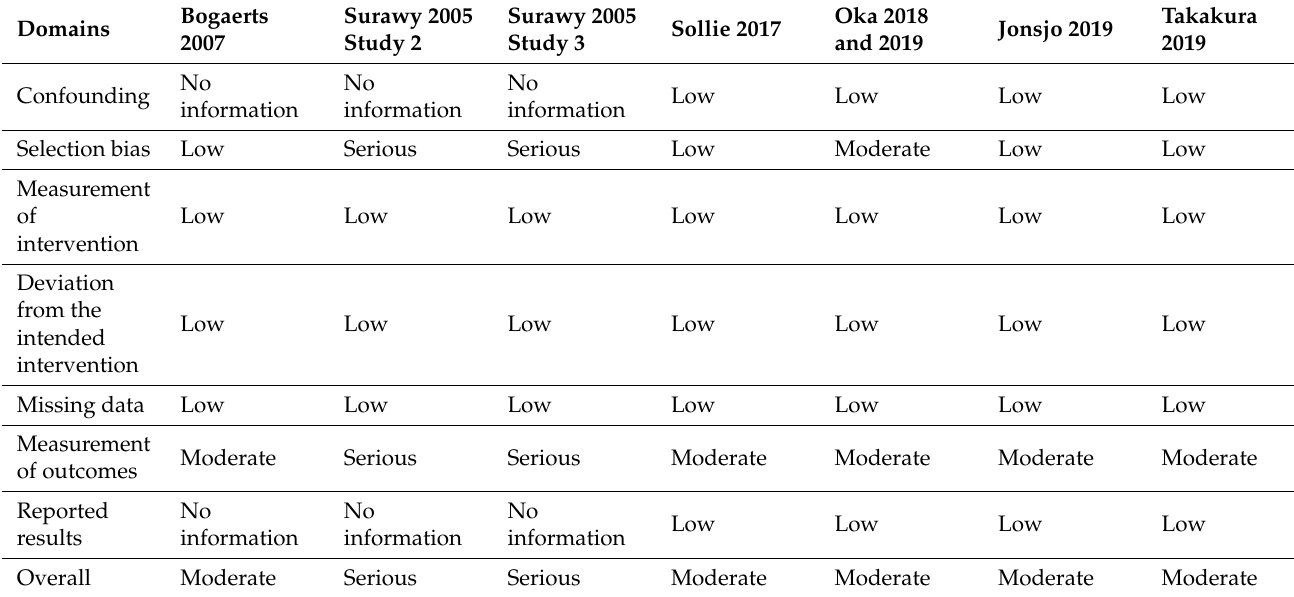
Table A5. Risk of Bias (ROBINS-I).